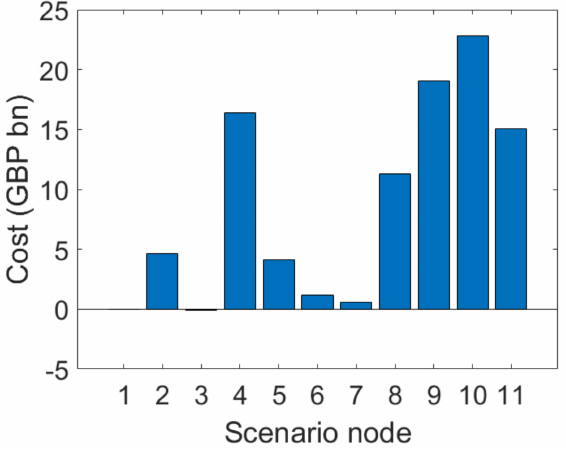
Figure 23. Difference between the optimal operation costs for the stochastic studies with and without storage, per scenario-tree node.